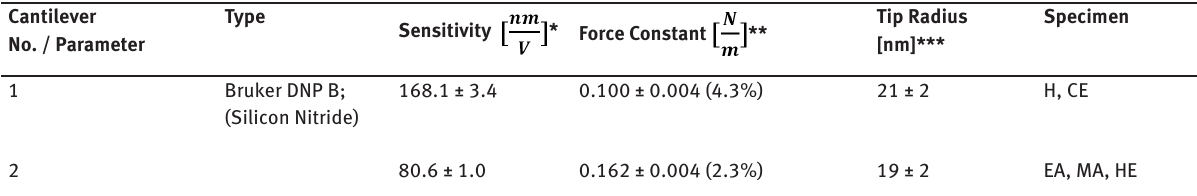
Table 2: Mechanical parameters of cantilevers and tips used for AFM.